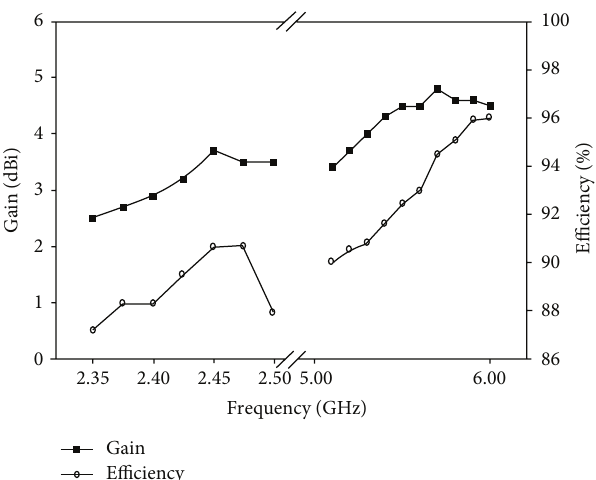
Figure 7: Measured radiation efficiency and peak gain of the pro- posed